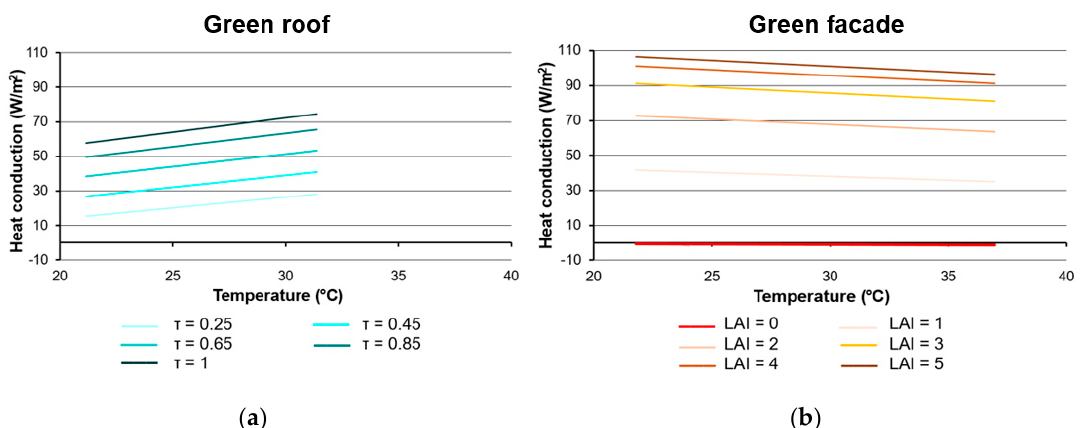
Figure 13. Sensitivity of ( a ) the heat conduction through the green roof to Transmissivity of radiation through the plant and ( b ) the heat reduction through the green façade to Leaf area index (LAI) for solar radiation of 800 W/m 2 and relative humidity of 50%.